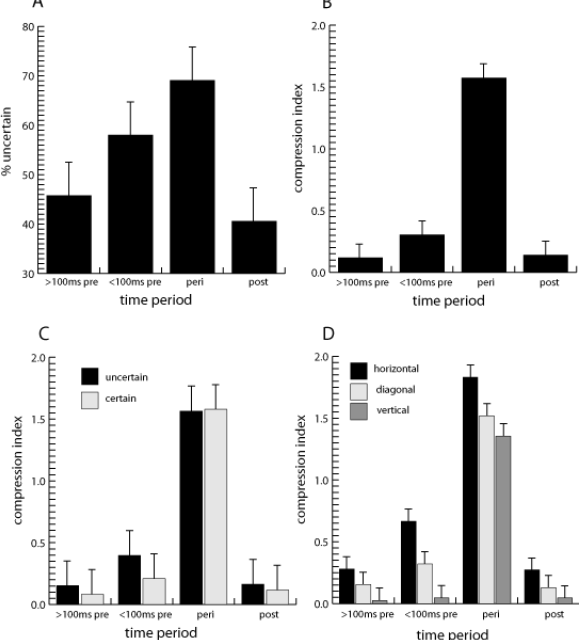
Figure 2: A. The percent of uncertain responses for judging stimuli appearing at different time points relative to the onset of the saccade. Note that uncertainty is largest immediately prior to and during a saccade. B. Compression (calculated as a mean of the perceived number minus actual number of squares) across the time periods. Note that compression is also largest immediately prior to and during a saccade. C. Compression as a function of both certainty and time period. Compression is influenced by time period, but not by certainty, and there is no interaction of certainty with time. D.The effect of orientation on compression is shown for each time period. The orientation effect interacts with time period, with the larger orientation effects immediately before and during the